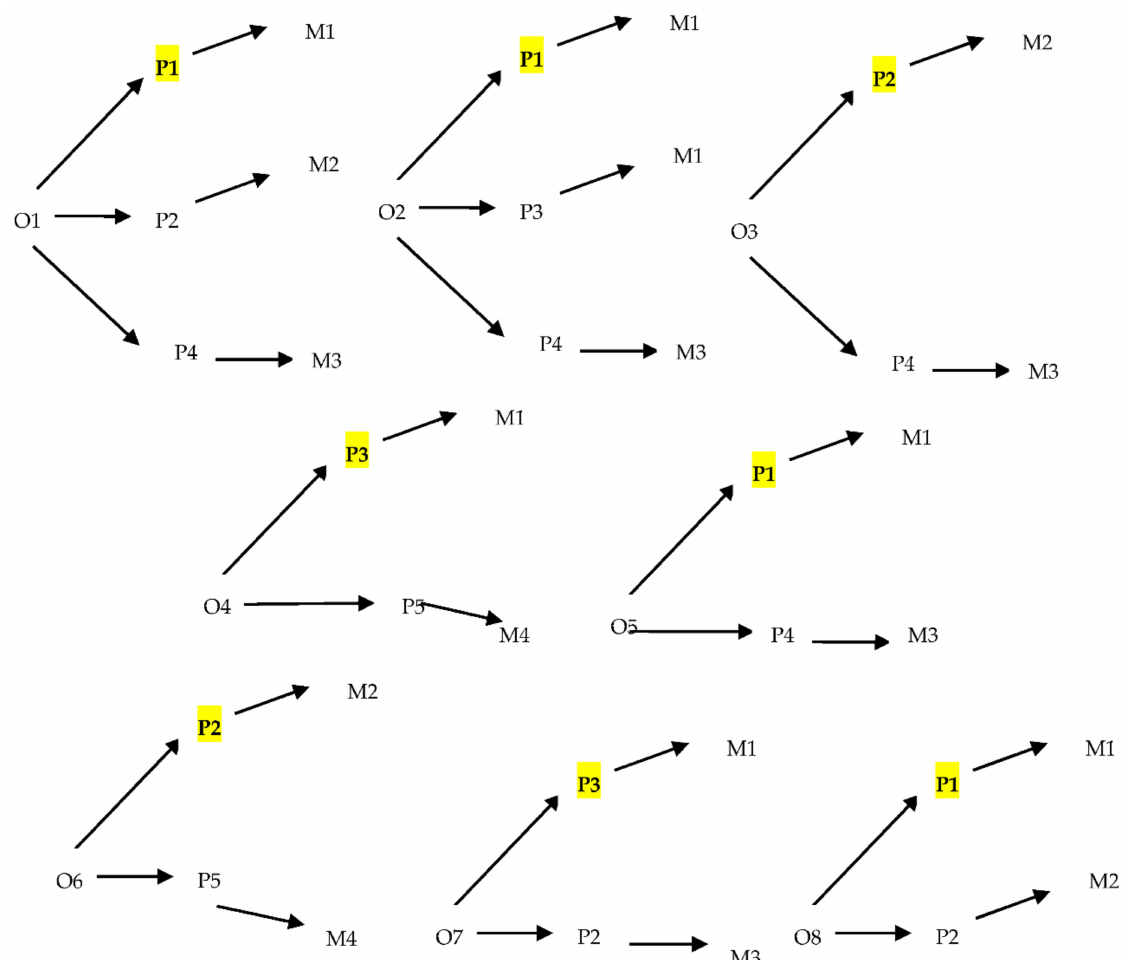
Figure 5. Best machine for process of each operation/sub-stage after implementation of the first